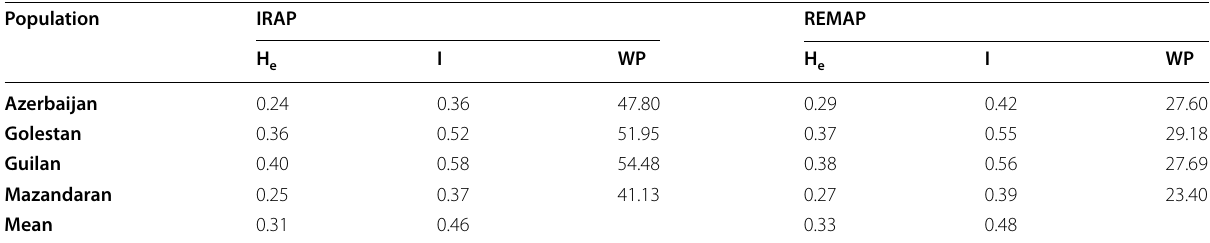
Table 4 Nei’s gene diversity (H ), Shannon’s information index of genetic diversity (I), and within-population variation (WP) of e geographical populations based on IRAP and REMAP data Population IRAP